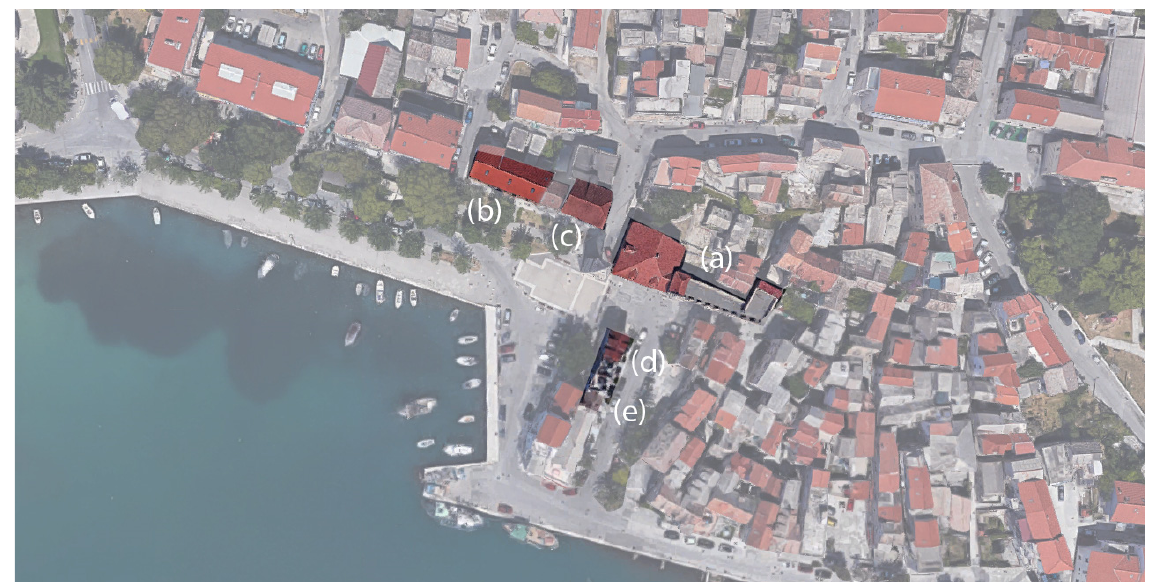
Figure 7. A view of Kaštela case study site and the five buildings analysed.